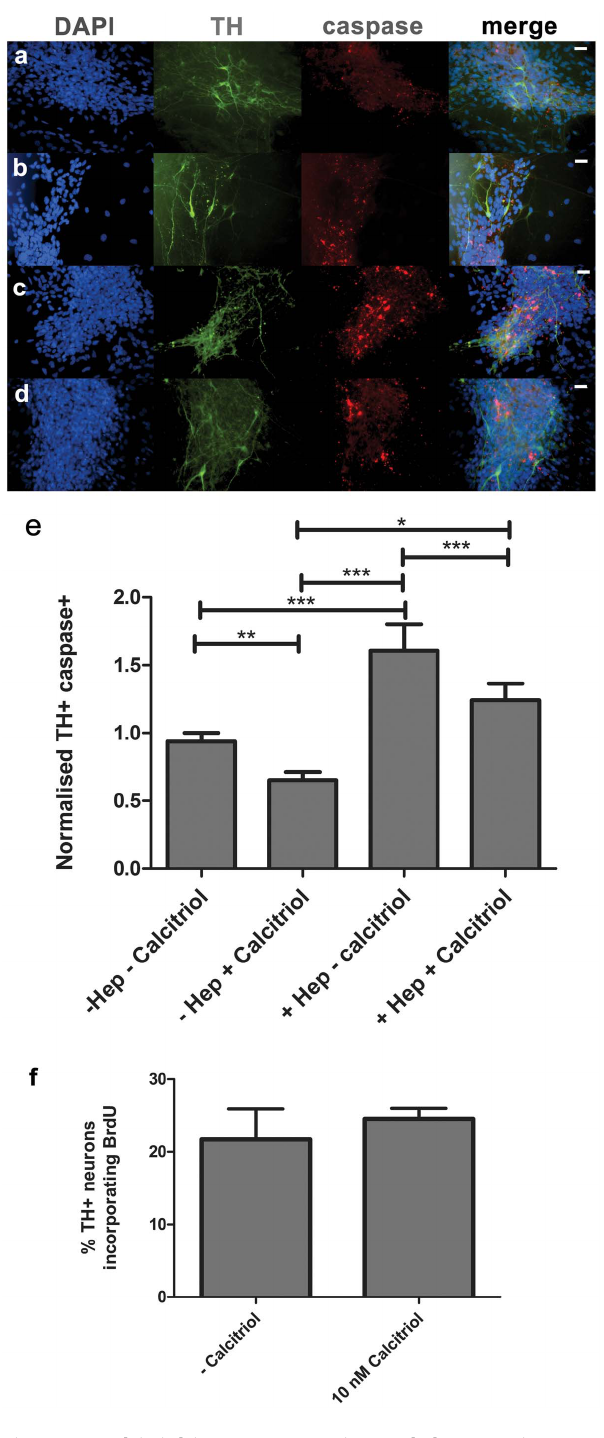
Figure 4. Calcitriol is neuroprotective and does not increase differentiation. The increase in dopamine neurons obtained from cultures was shown to be a result of increased neuroprotection afforded through calcitriol addition, rather than changes in differenti- ation. (A–D) Immunolabeling with a pan-caspase marker (red) and antibodies to tyrosine hydroxylase (green) counterstained with DAPI (blue), for: A) control media, B) 10 nM calcitriol, C) 0.3 U/ml Heparinase III and D) 10 nM calcitriol with 0.3 U/ml heparinase III. Scale bars: 20 m M. E) The number of apoptotic dopamine neurons was significantly increased when heparinase III was added to media. Bars represent the ratio of caspase + dopamine neurons to caspase + DAPI + cells. Error